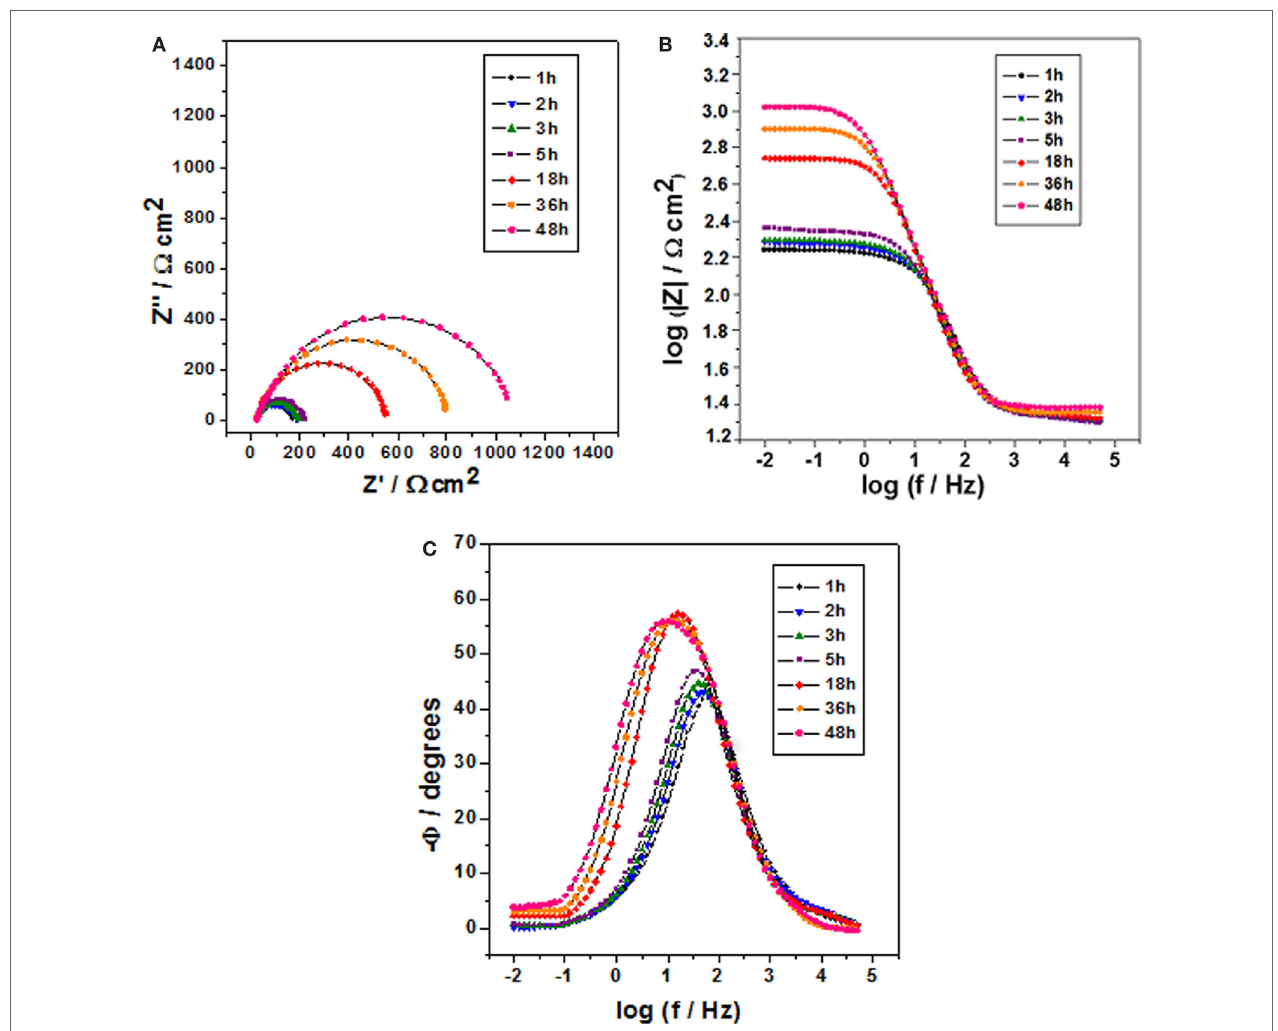
FigUre 3 | impedance diagrams: nyquist (a) and Bode (B,c) plots for carbon steel after different immersion times in 0.1 mol/l nacl at ph 2 and containing 1 wt.% of halloysite nanotubes with encapsulated dodecylamine